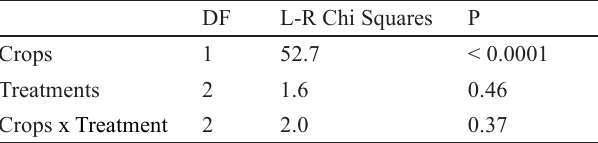
Table 3 . Poisson test for comparison of number of main trunk per tree between crops (mango and cashew) and treatments (ants, ants feeding and ants + GF-120). N = 432